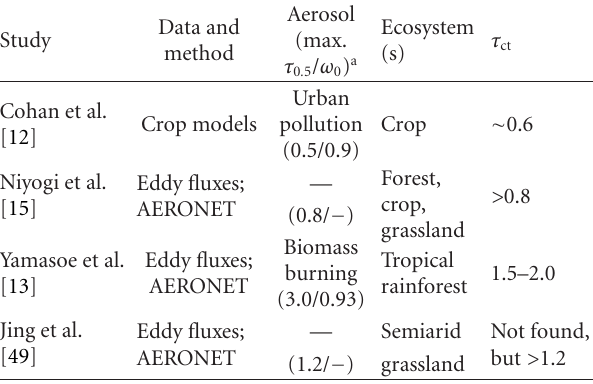
Table 2: Comparison of past studies on the aerosol impact on PAR and plant photosynthesis in cloud-free